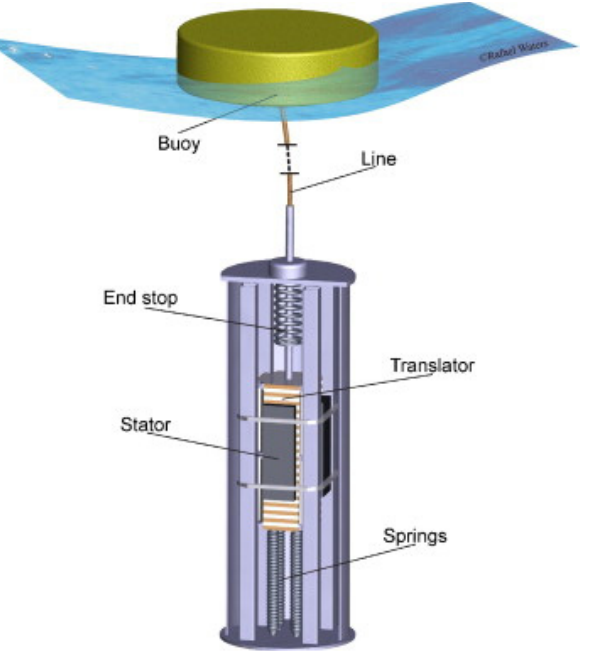
Figure 18. Working principle of Lysekil project (Reproduced with permission 5139260046167 from [32], Elsevier, 2010).